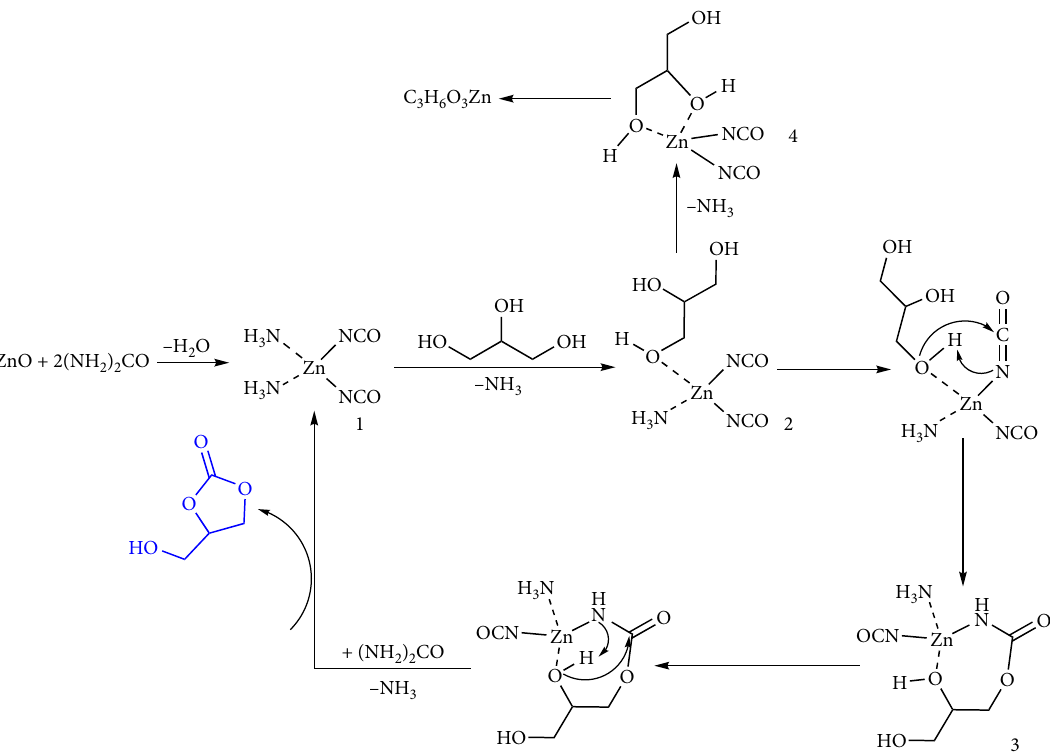
Scheme 6: The possible reaction mechanism for GC synthesis from glycerol and urea using Zn-containing